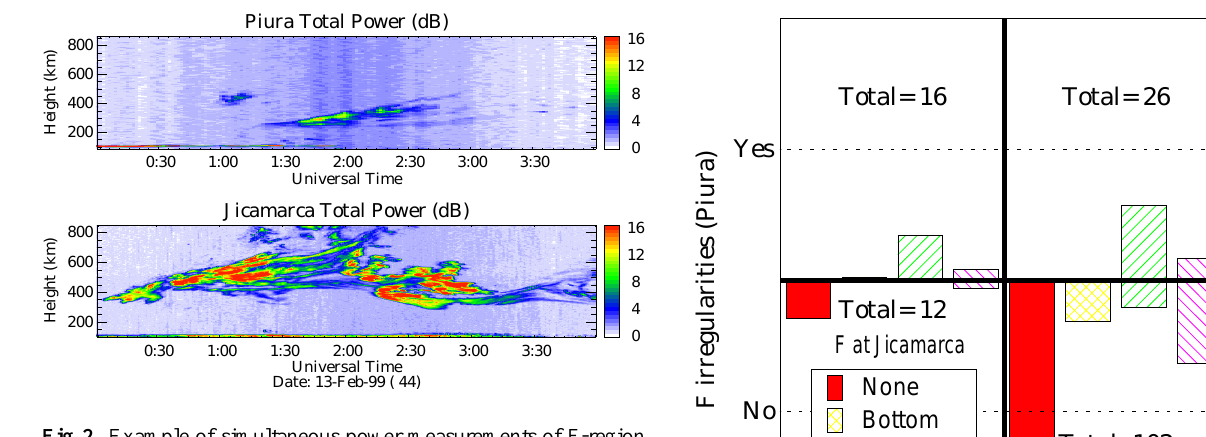
Fig.2. Example of simultaneous power measurements of F-region field-aligned irregularities with the Piura (top) and Jicamarca (bot- tom) VHF radars.